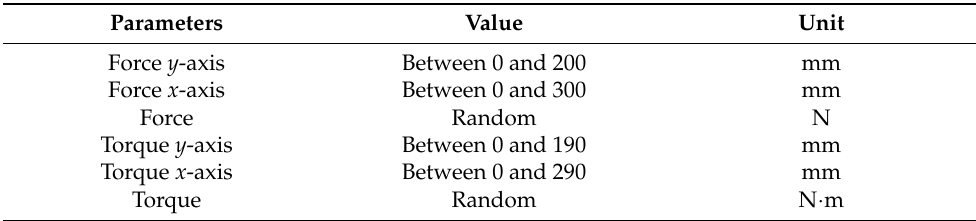
Figure 3. System simulation process: ( a ) Simulation model loaded state; ( b ) Simulation model loaded state (Left view); ( c ) Total deformation cloud of simulation model. Table 1. The material properties of the structural specimen. Table 2. Input parameter information